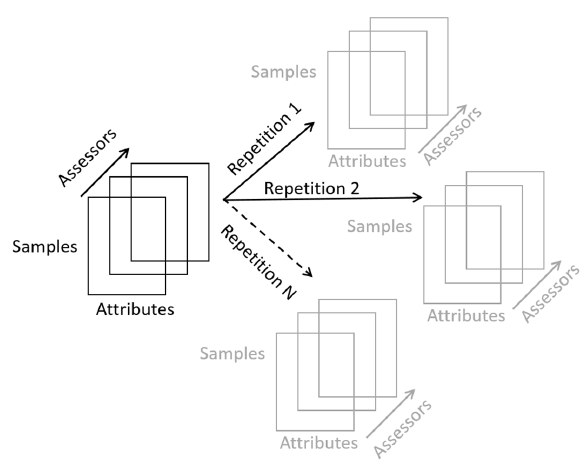
Figure 2. Classical four-way data structure of sensory data (based on [13]). Mostly ANOVA models are used on mean sensory data with the design of experiment (DoE) parameters as factors. Sensory data are first averaged across panelists and replicates, then with the help of DoE parameters (fixed effects) ANOVA models are run on these data. Mixed models on raw sensory data have the subject as a random effect and DoE parameters as fixed effects. In the case of panel performance examinations, significant effects and interactions are chosen [52]. For panel performance tests, only the full factorial design is used. However, balanced incomplete block design (BIBD) is also applied in tests with a high number of samples